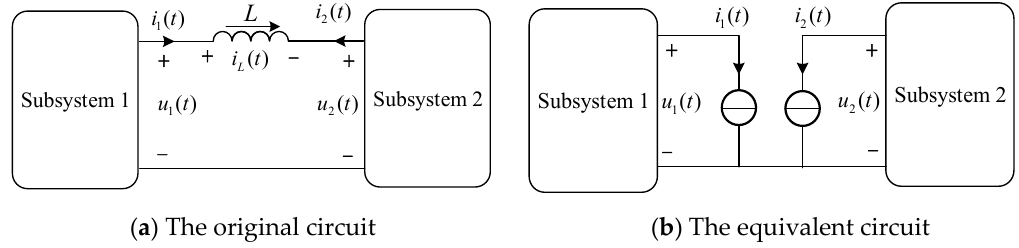
Figure 2. The equivalent diagram of the inductance branch. ( )